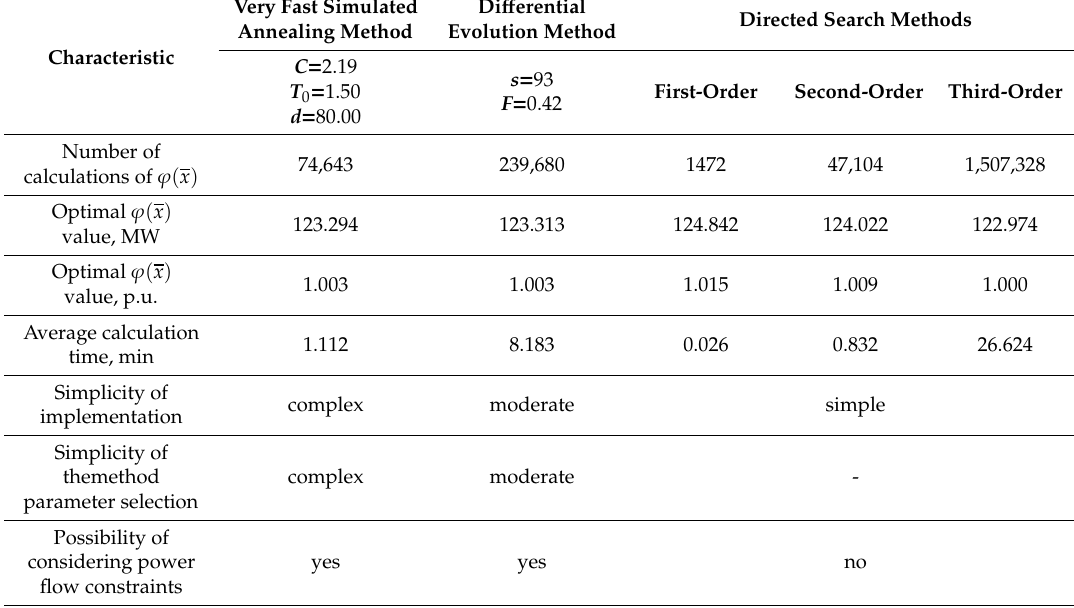
Table 6. Maintenance scheduling results for the second test